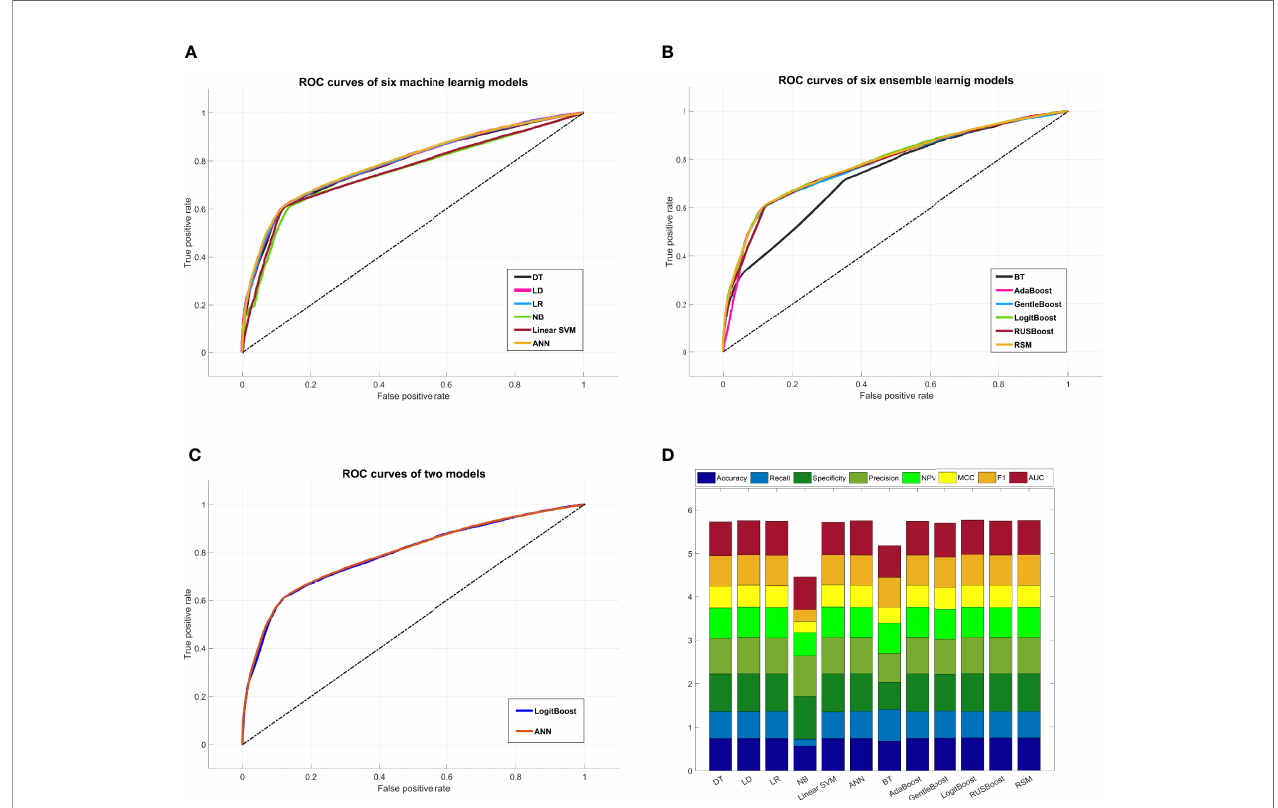
FIGURE 5 | Comprehensive comparison of all models. (A) Comprehensive ROC curves of six machine learning models: the larger the area under the curve, the better the performance. (B) Comprehensive ROC curves of six ensemble learning models. (C) Comprehensive comparison of two ROC curves: ANN model, i.e., the best machine learning model, and LogitBoost model, i.e., the best ensemble learning model. (D) In this histogram, the metrics of twelve models, including accuracy, recall, speci fi city, precision, NPV, MCC, F1, and AUC, are stacked into columns; hence, the higher the column, the better the performance. ROC, receiver operating characteristic; ANN, arti fi cial neural network; NPV, negative predictive value; MCC, Matthews correlation coef fi